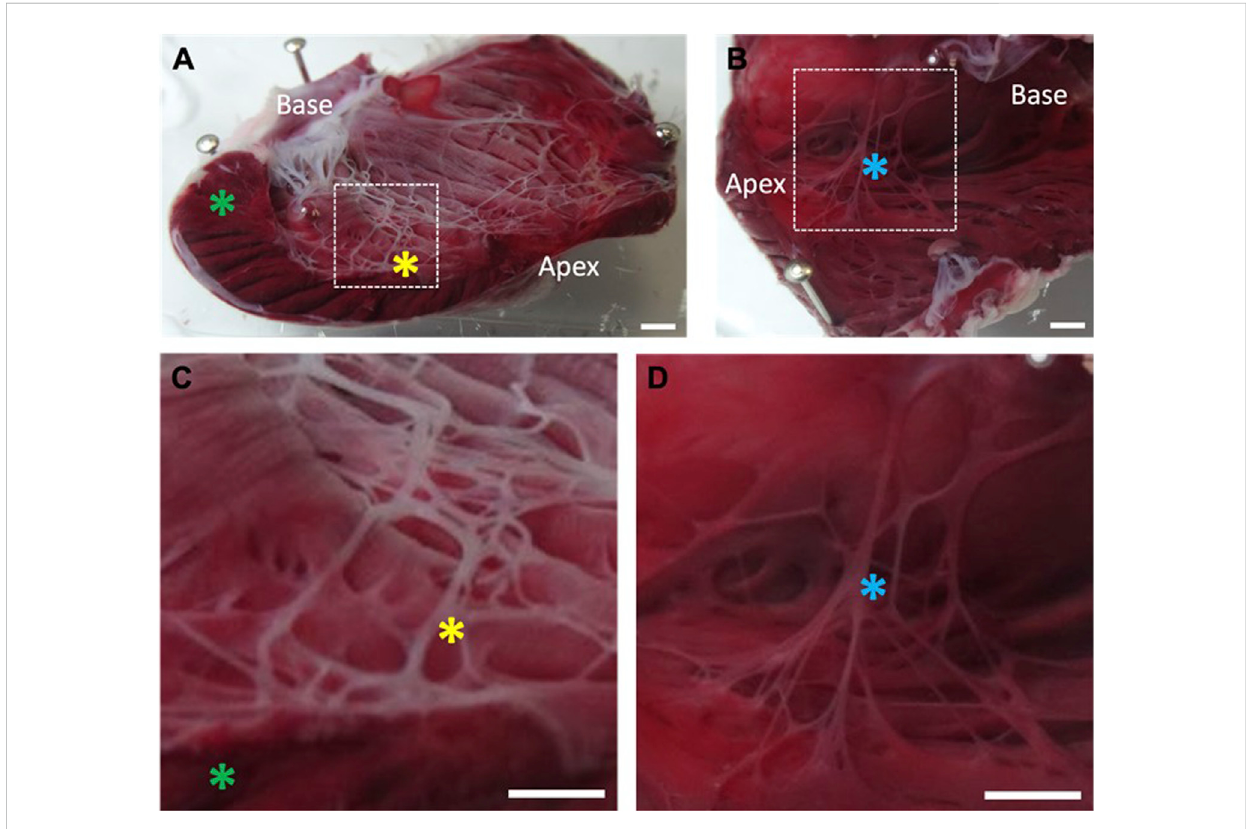
FIGURE 3 Location of necrotic tissue on the left ventricular endocardial surface following exposure to Lugol. The left ventricular (LV) lumen of isolated Langendorff perfused rabbit hearts were exposed to 0.5 mL Lugol (120 mM KI, 38.6 mM I 2 ) solution for 10 s, followed by a Tyrode wash. Hearts were stained with TTC and fi xed in 10% formalin prior to imaging. (A) LV, with incision through the free wall. The Purkinje fi bre network stains as a white meshwork indicating necrosis. The endocardial surface shows a thin layer of necrosis that is not universal, while the LV bulk myocardium is unaffected (greenasterick).Prominent,ablatedPurkinje fi bresarevisible(yellow asterick). (B) Absence ofnecrotictissue ontheuntreated RVendocardial surfacefromthesameheart,withPurkinje fi bresstainingashealthytissue(blueasterick). (C,D) Magni fi edviewoftheareaindicatedbydashedboxin (A,B) respectively. Individual Purkinje fi bres are necrotic after exposure to Lugol(C; yellowasterick), but intact within theRV (D; blueasterick)intheabsenceof Lugol. Scale bars, (A – D) : 2